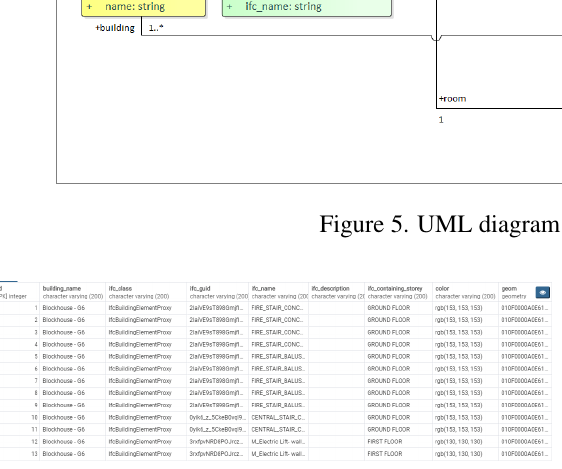
Figure 6. Example of a table created in PostgreSQL to store a IFC building